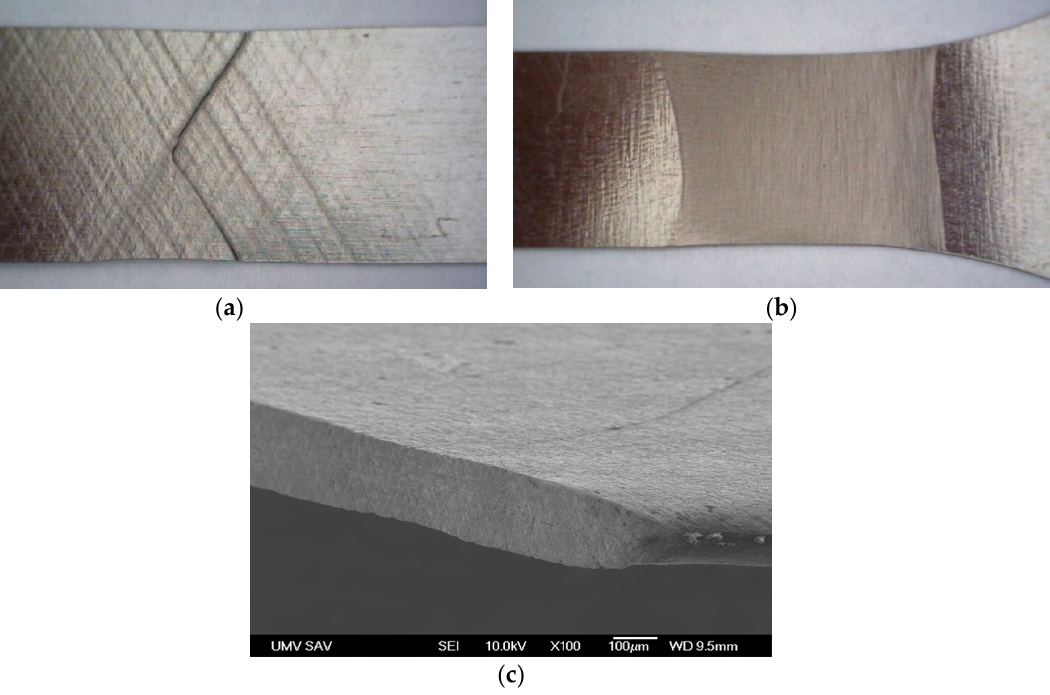
Figure 8. Example of the fracture of the test specimens during the uniaxial tensile test: ( a ) fracture of the specimen No. 27; ( b ) local deformation of the specimen No. 18; ( c ) fracture of the specimen No. 18 after considerable contraction of the material.